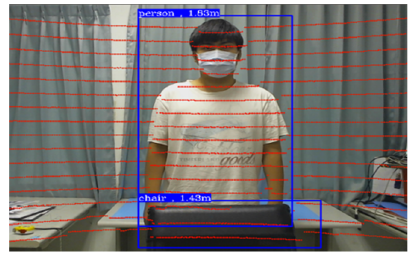
Figure 17. Measuring distance using the medium point within the bounding box.